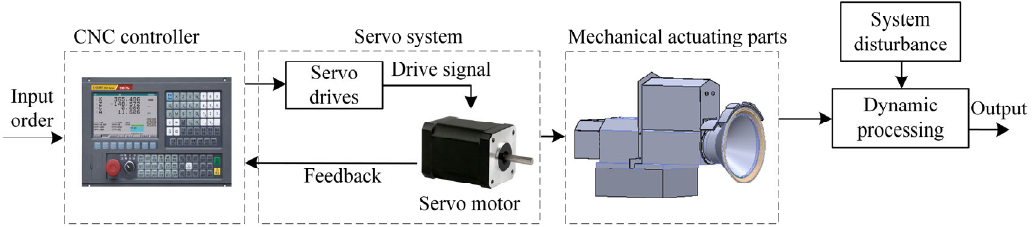
Figure 1. Traditional CNC system of machine tool.